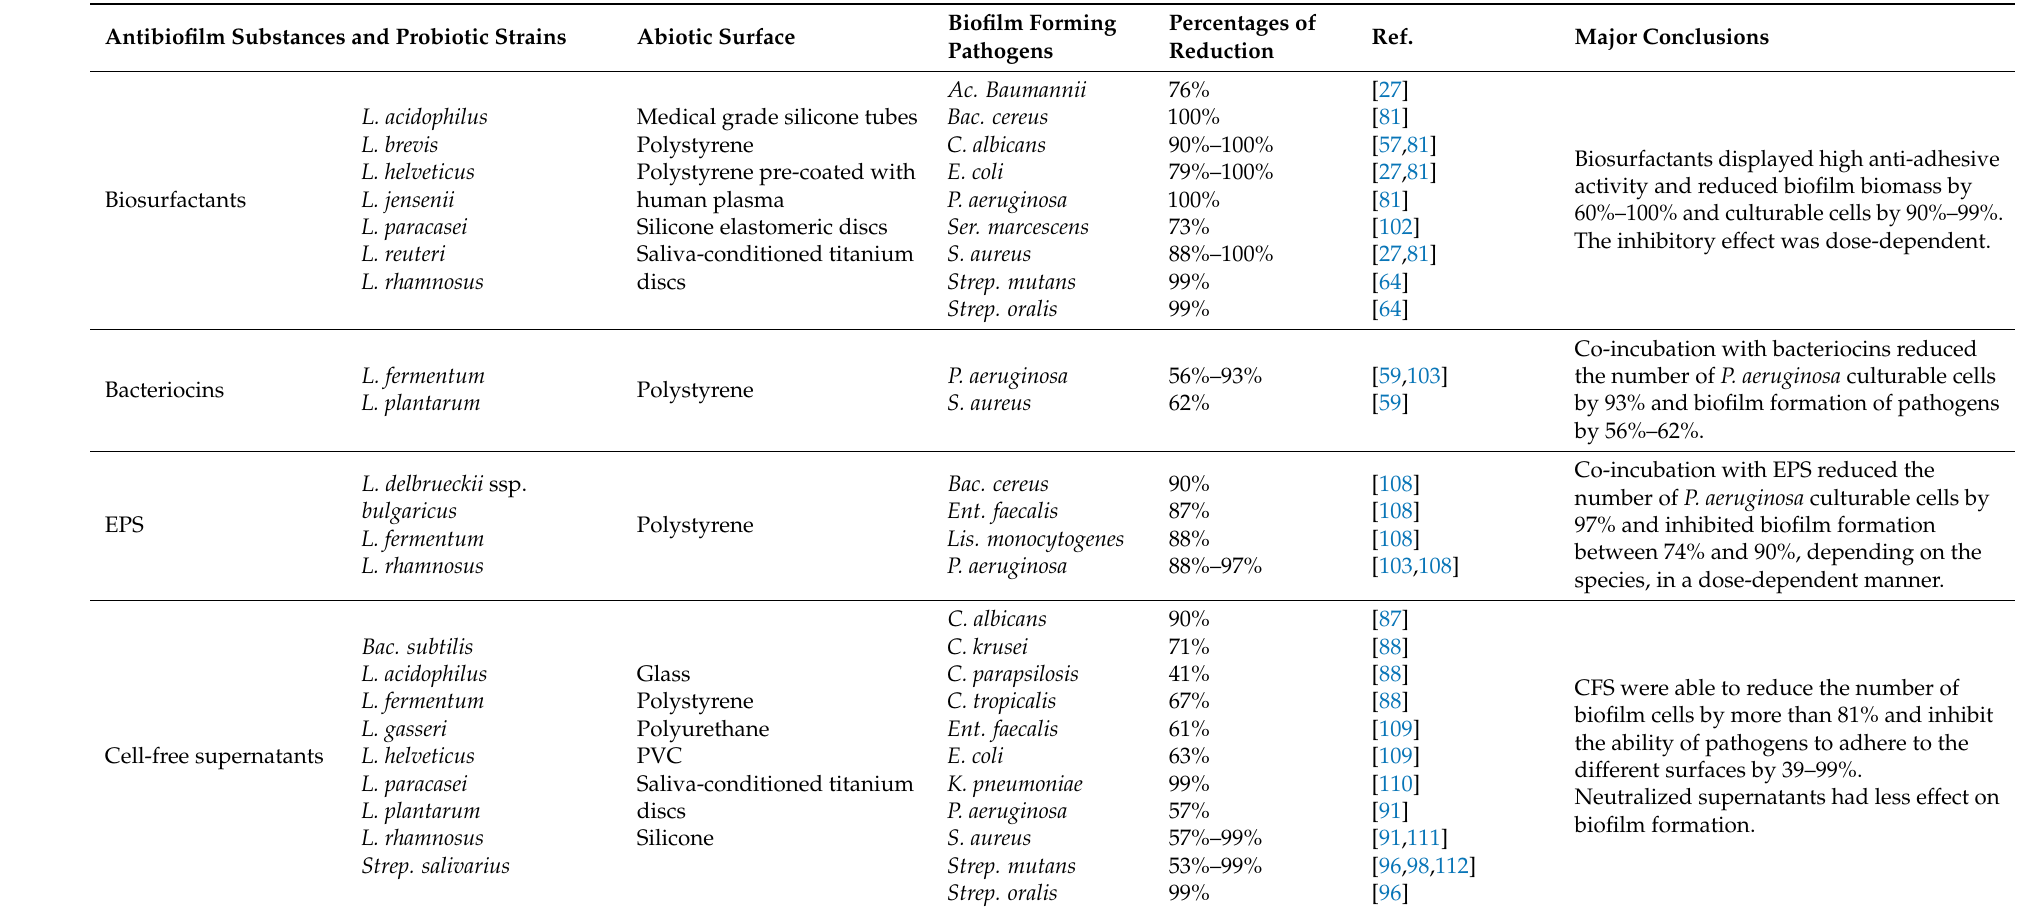
Table 3. Competition studies in medical